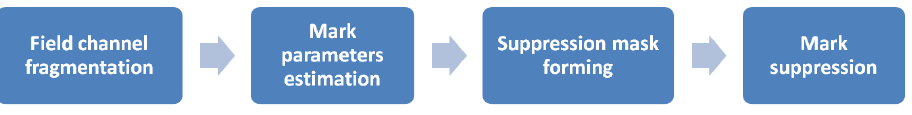
Fig. 1. The visual scheme of adaptive clutter suppression